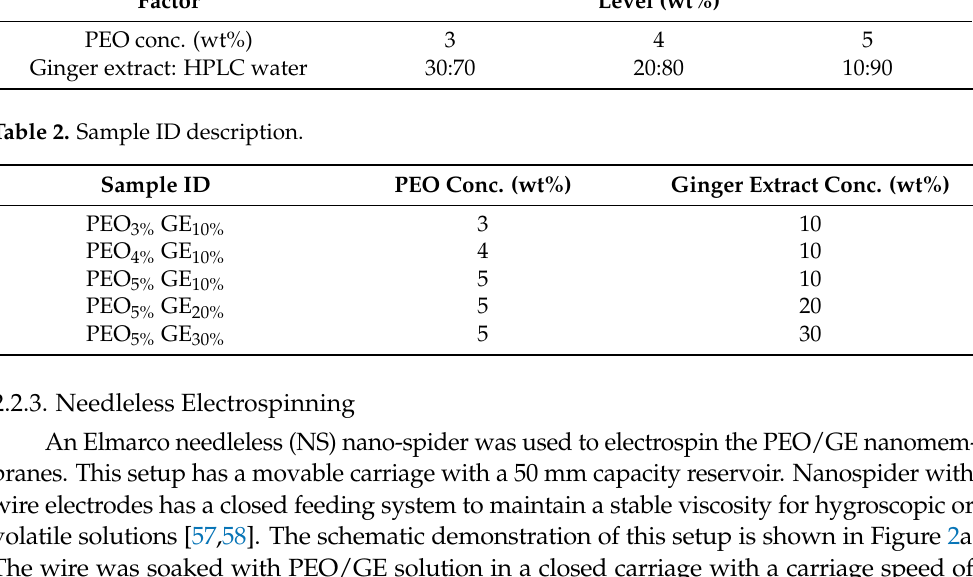
Table 1. Design of the experiment (DOE). Table 2. Sample ID description.